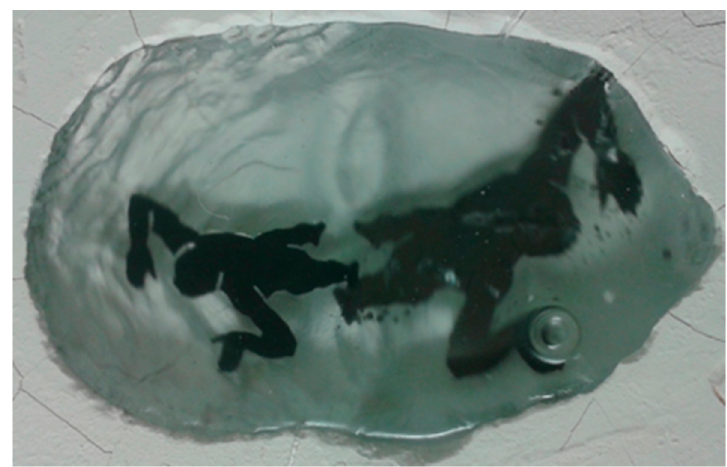
Figure 9. Inclusion of nickel 825 alloy coated with black graphite; created by author. Arts 2019 , 8 , x FOR PEER REVIEW